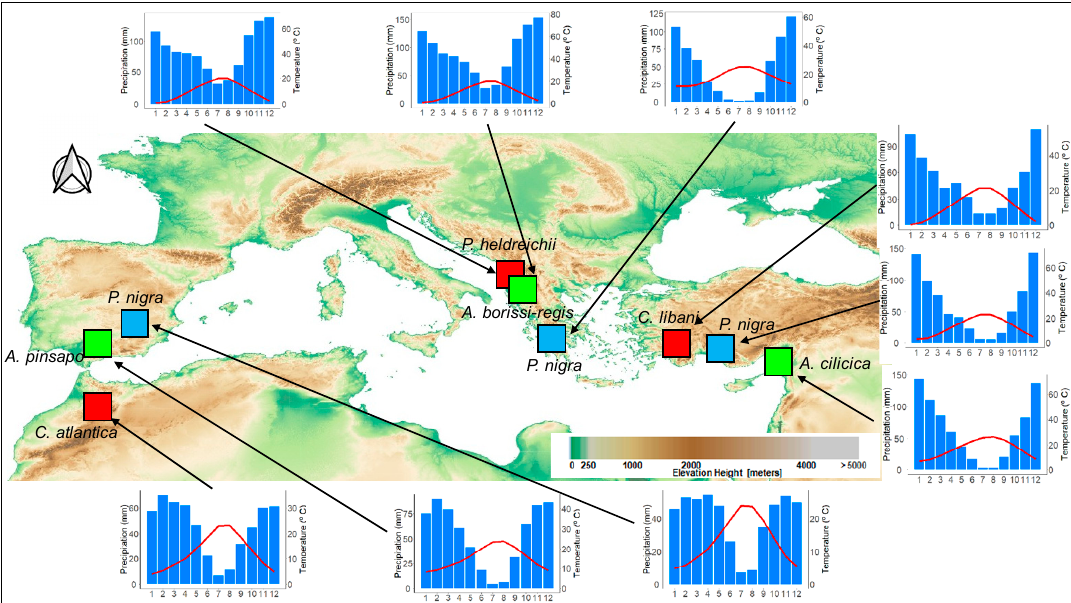
Figure 1. Map showing the geographic locations of the study sites in the Mediterranean Basin and the digital elevation model in the background. Colored squares represent the studied species in green ( Abies pinsapo, A. borissi-regis, A. cilicica ), blue ( Pinus nigra ), and red ( Cedrus atlantica, C. libani and P. heldreichii ) populations, respectively. Climatic diagrams for each study site (mean temperature, red lines; precipitation, blue areas) are shown.